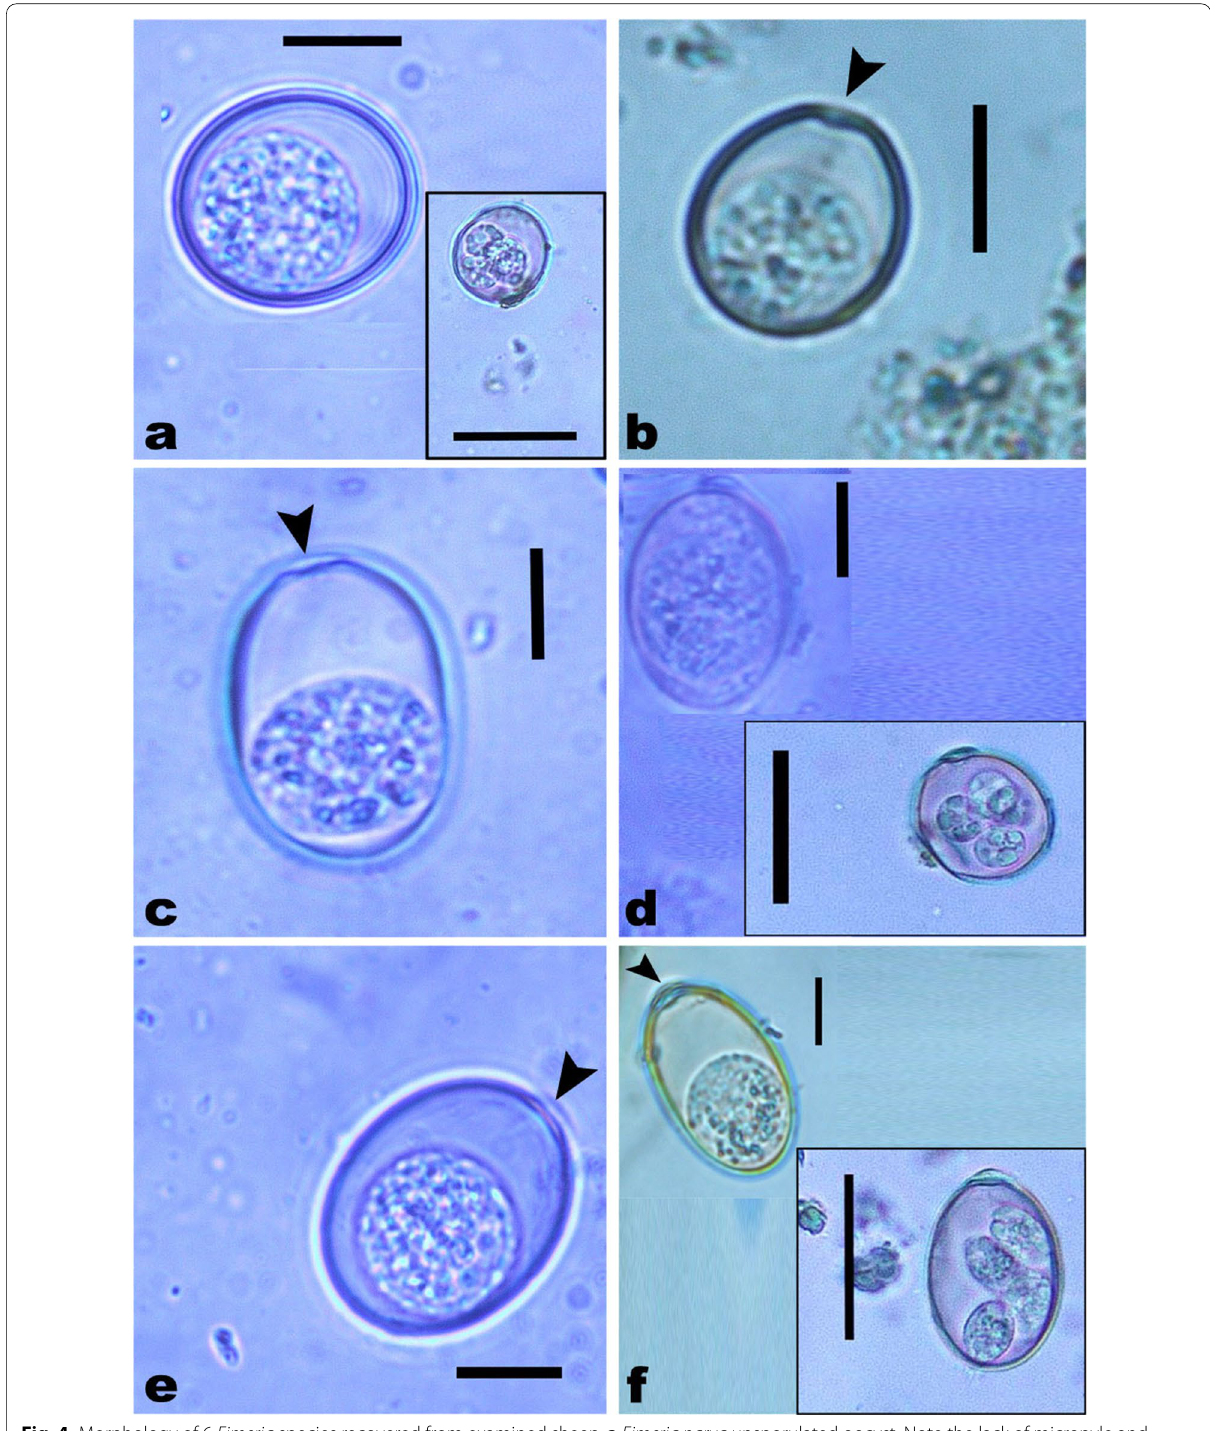
Fig. 4 Morphology of 6 Eimeria species recovered from examined sheep. a Eimeria parva unsporulated oocyst. Note the lack of micropyle and polar cap. Inset: The sporulated oocyst has ovoid sporocyst, each sporozoite has central vacuole Scale bar oocyst. Note the imperceptible micropyle (arrowhead). c Eimeria marsica unsporulated oocyst. Note the inconspicuous micropyle (arrowhead). d Eimeria crandallis unsporulated oocyst and sporulated oocyst. Inset: The sporulated oocyst has rounded or ovoid sporocyst and each has two vacuoles Scale bar 25 µm. e Eimeria ovinoidalis unsporulated oocyst. Note the presence of micropyle without a polar cap (arrowhead). f Eimeria = arloingi unsporulated oocyst. Note a distinct micropyle and the polar cap is lid‑like and easily dislodged (arrowhead). Scale bar sporulated oocyst has elongated sporocysts and their sporozoite has large vacuole at the broad end. Scale bar